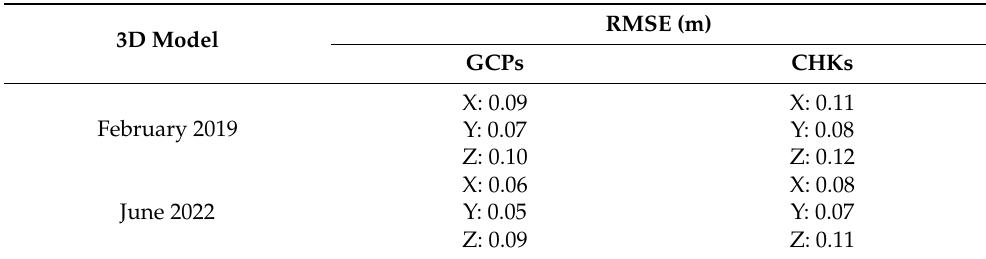
Table 2. Accuracy of the UAV 3D models.